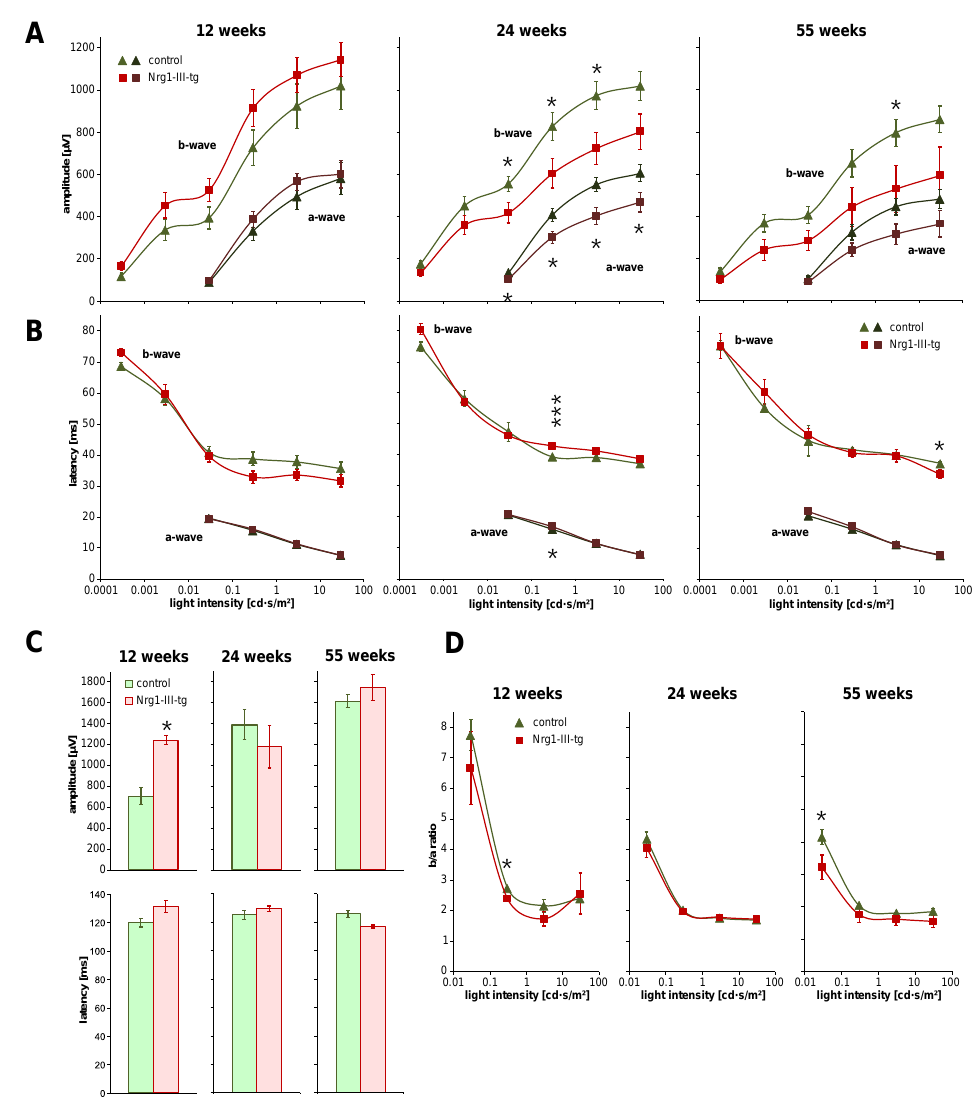
Figure 1. ERG Parameters in 12-, 24 and 55-week control and transgenic mice. Scotopic amplitudes ( A ) and latencies ( B ) of a-waves and b-waves at different light intensities as indicated: ( C ): amplitudes and latencies of scotopic oscillatory potentials; ( D ): the ratio of amplitudes of b-waves and a-waves. Number of animals at the age of 12, 24 and 55 weeks: n = 8, n = 13 and n = 9 control mice and n = 6, n = 5 and n = 8 Nrg1-III-tg age-matched mice, respectively. Data are shown as mean values. Error bars show standard error of means. Statistical significance of differences is indicated as follows: * p < 0.05, *** p < 0.001.